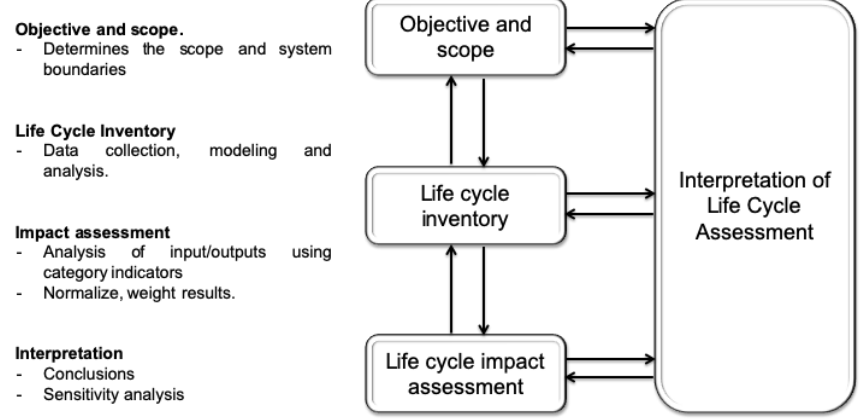
Figure 1. Life cycle assessment (LCA) structure. Adapted from ISO 140403.2. Review Methodology.